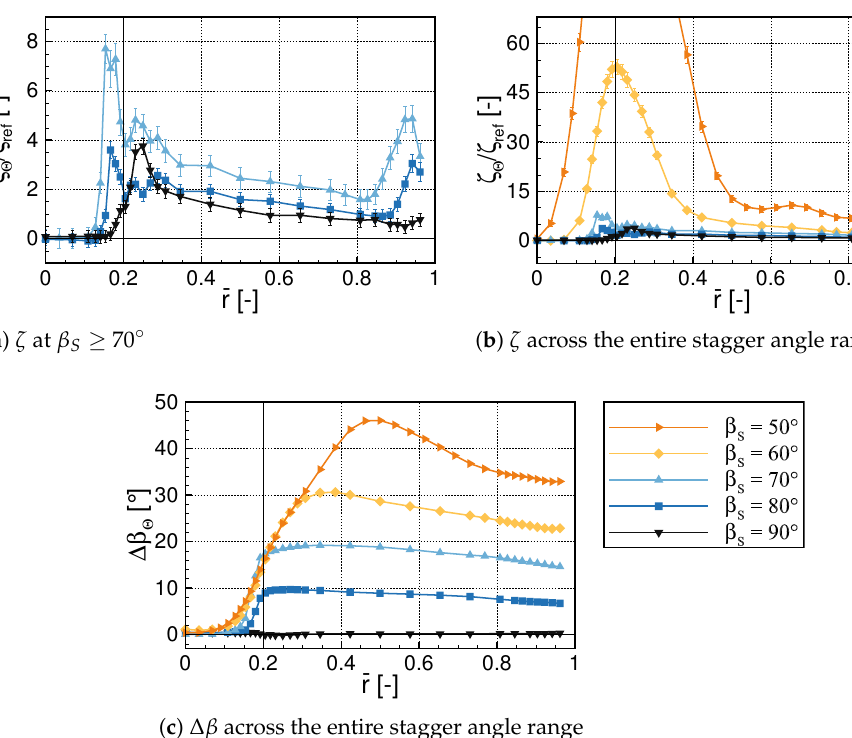
Figure 8. Radial loss and deflection